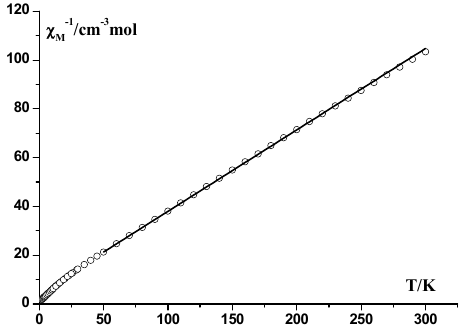
Figure 6. χ M-1 vs. T Plot for catena -[Co(µ 1,5 -dca) 2 (4-MOP–NO) 2 ] ( 1 ). The Curie–Weiss law; the best fit is given as a solid line.